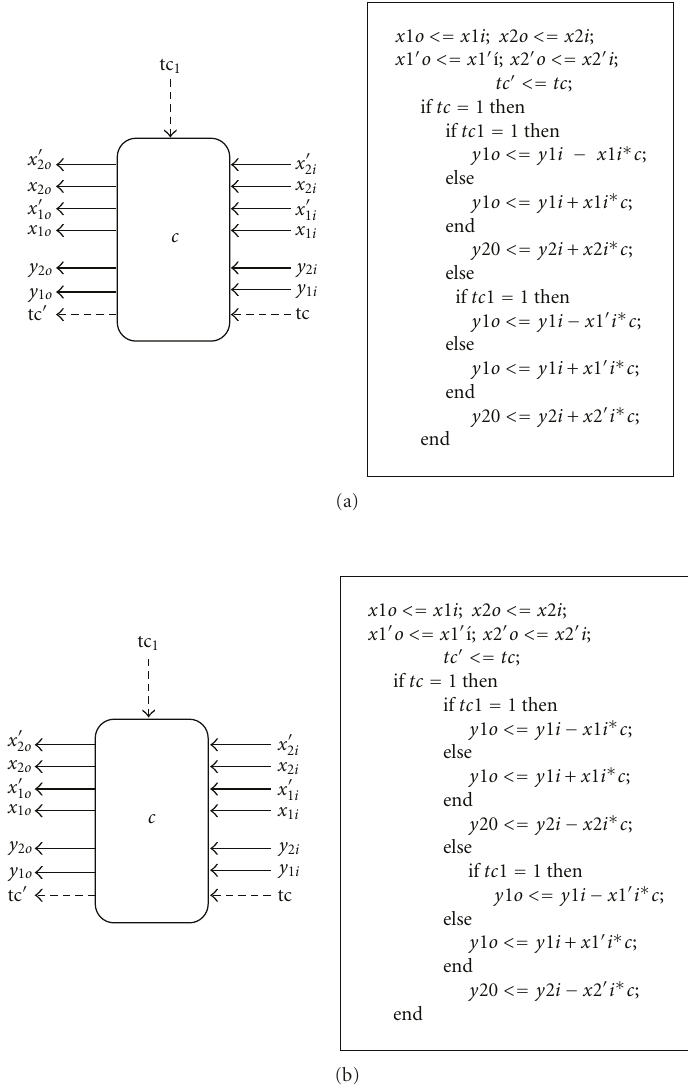
Figure 3: Functionality of the processing element PE in Figure 2(a). Functionality of the processing element PE in Figure 2(b).